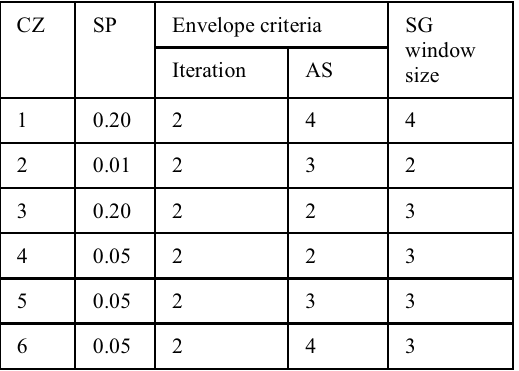
Table 1. Variable settings of parameters of Savitzky-Golay filter of TIMESAT over different calibration zones.(CZ: Calibration Zones, SP: Seasonality Parameters, AS: Adaptation